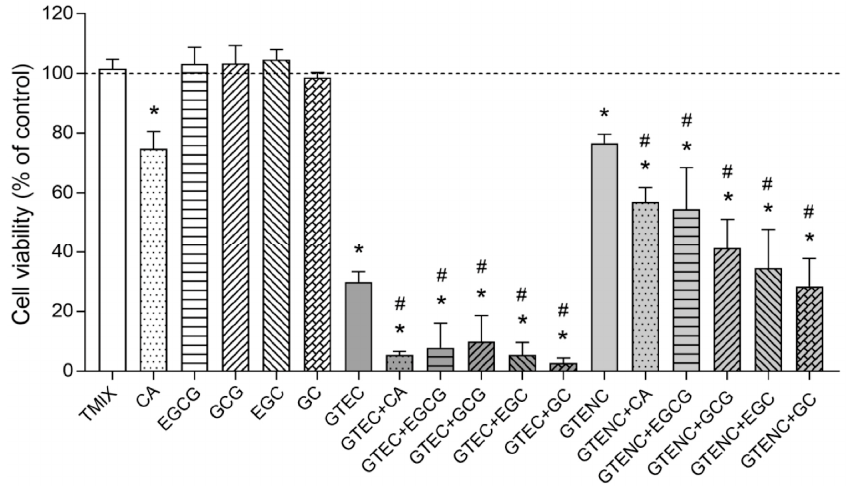
Figure 4. Antiproliferative activity of green tea extract (GTE). HL-60 cells were challenged with fresh (GTEC) and purified (GTENC) extracts in the absence or presence of pure caffeine (CA), epigallocatechin gallate (EGCG), gallocatechin gallate (GCG), epigallocatechin (EGC), or gallocatechin (GC). for 24 h at the concentrations indicated in Table 3 of the Experimental Design. Cells were also treated with GTE’s major individual phenolic compounds and the mixture of them (TMIX) at the same conditions. The dashed line represents control (untreated) samples. Results are shown as means ± SD of six independent experiments run in triplicate. * p < 0.05 vs. untreated samples (100% of cell viability; Tukey’s multiple test). # p < 0.05 between doped extracts and their corresponding non-doped extract (Tukey’s multiple test).